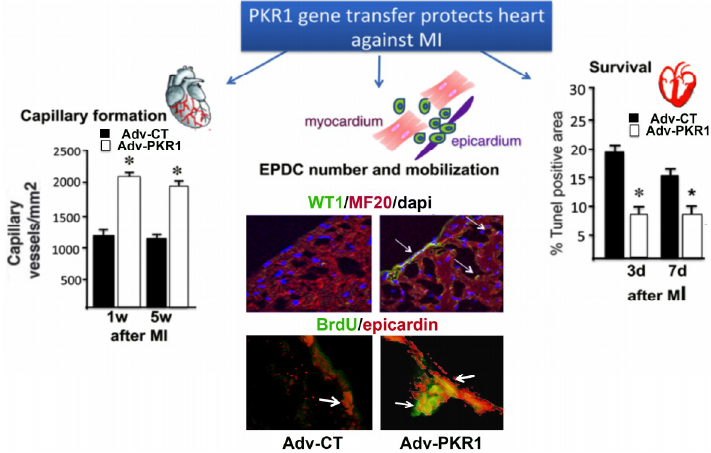
Figure 4. Mechanisms by, which PKR1 gene therapy may protect the heart against damage caused by myocardial infarction. One of the possible mechanisms involves the direct activation of endothelial cells to promote angiogenesis. Capillary numbers were increased in Adenovirus (Adv)-PKR1 treated hearts as compared to Adv-control treated hearts one week and five weeks after the coronary ligation as a mouse model of myocardial infarction (MI). Alternatively, EPDCs may be mobilized from the epicardium to the scar area, to regenerate the heart. WT1 staining of cryosectioned hearts revealed that WT1 positive (green) cell number in the niche and their mobilizations towards MF-20 positive (red) cardiomyocytes were increased in the Adv-PKR1 treated hearts as compared to Adv-control treated hearts one week after MI. A third possible mechanism involves the inhibition of apoptosis in cardiomyocytes. Tunel assay revealed that Adv-PKR1 treated hearts had lower levels of apoptotic cardiomyocytes as compared to Adv-control treated hearts three and seven days after